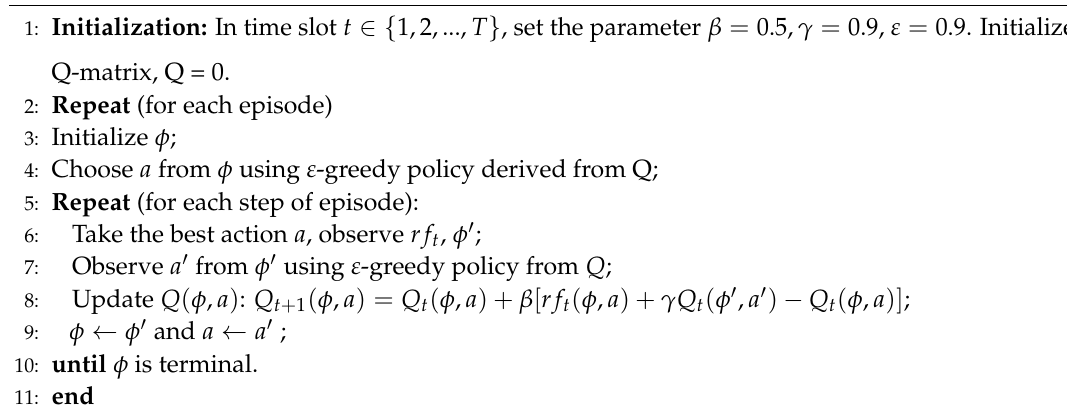
Algorithm 1 Cooperative Renewable Energy Sharing Algorithm